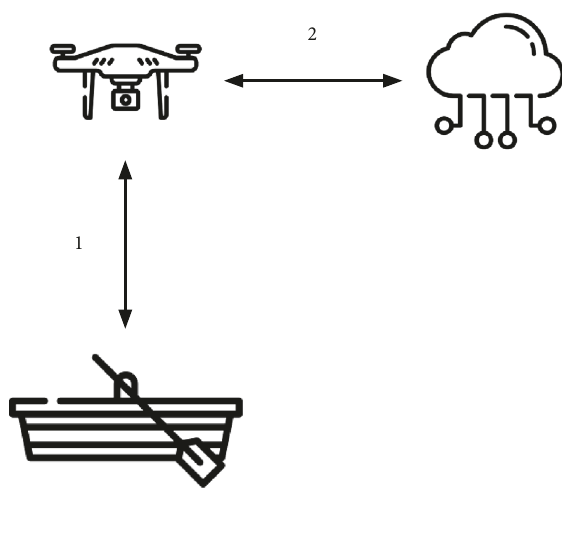
Figure 11: Attacking